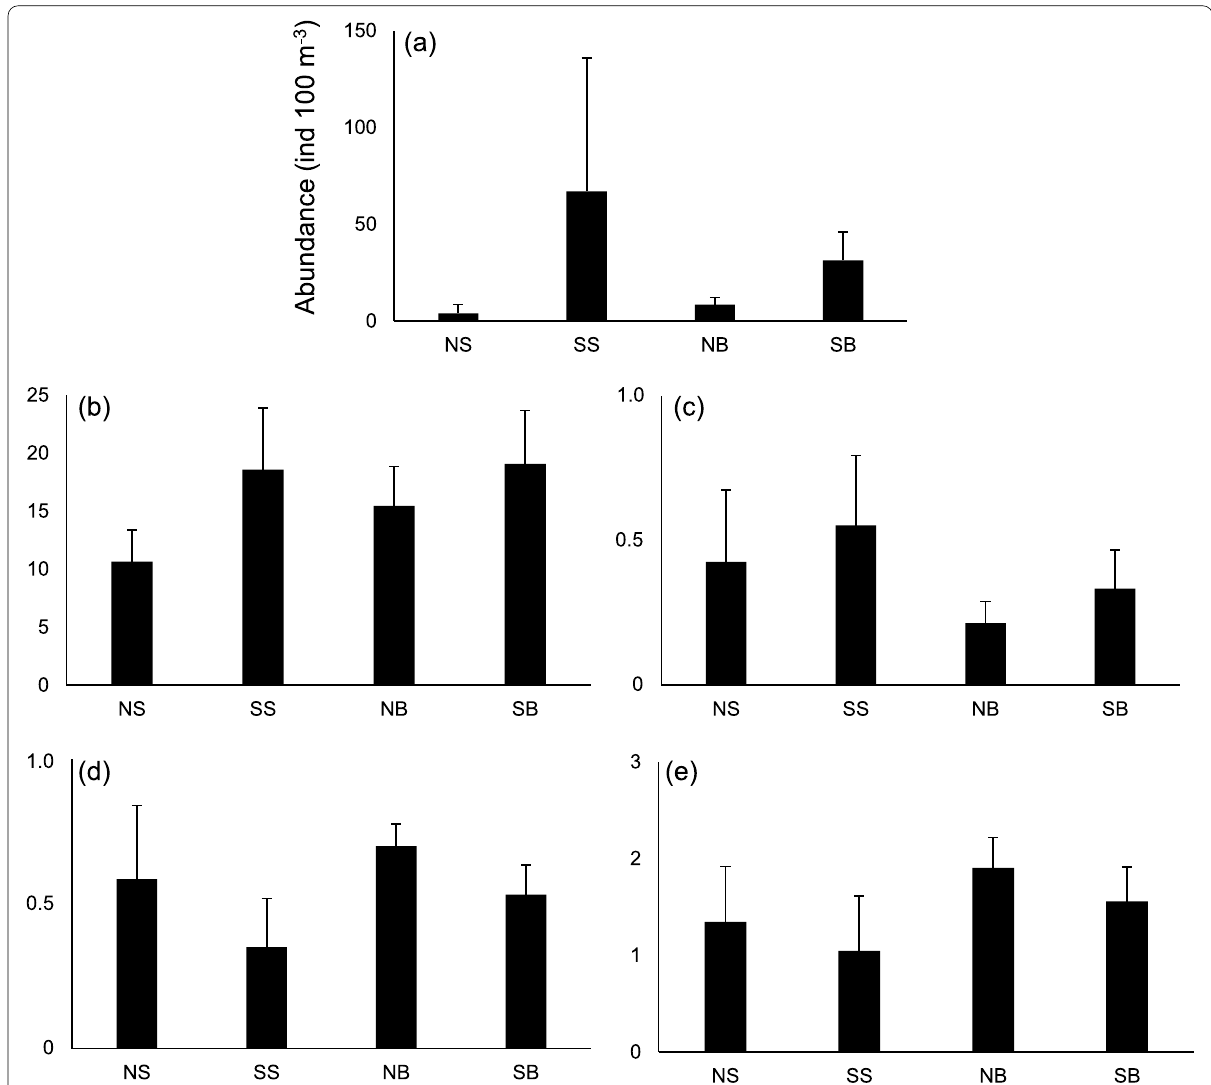
Fig. 6 Average values of total abundance and alpha diversity of zooplankton in the Caucahué Channel, obtained for significantly different northern and southern groupings. a Total abundance (Ind 100 m − 3 ), b Species richness, c Simpson dominance, d Pielou Evenness, e Shannon–Wiener diversity. Bars represent standard deviation. NS: Northern surface layer, SS: Southern surface layer, NB: Northern deeper layer, and SB: Southern deeper